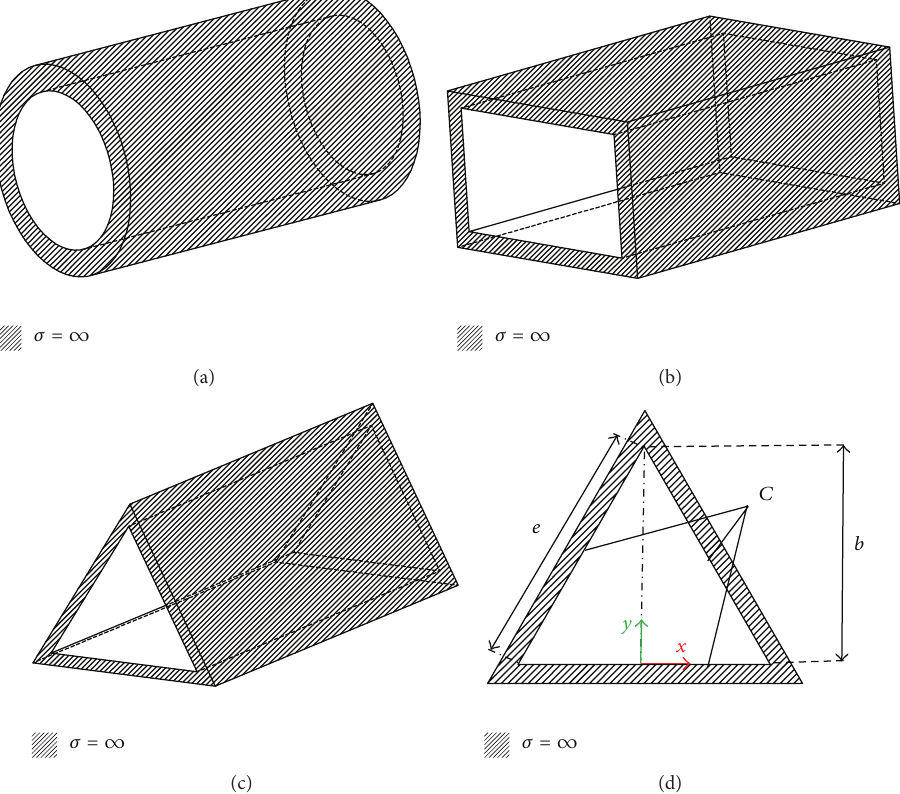
Figure 1: (a) Classical circular waveguide, (b) classical rectangular waveguide, (c) equilateral triangular waveguide of this paper, and (d) reference coordinate system used. Conductivity 𝜎 = ∞ indicates a perfect electric wall boundary